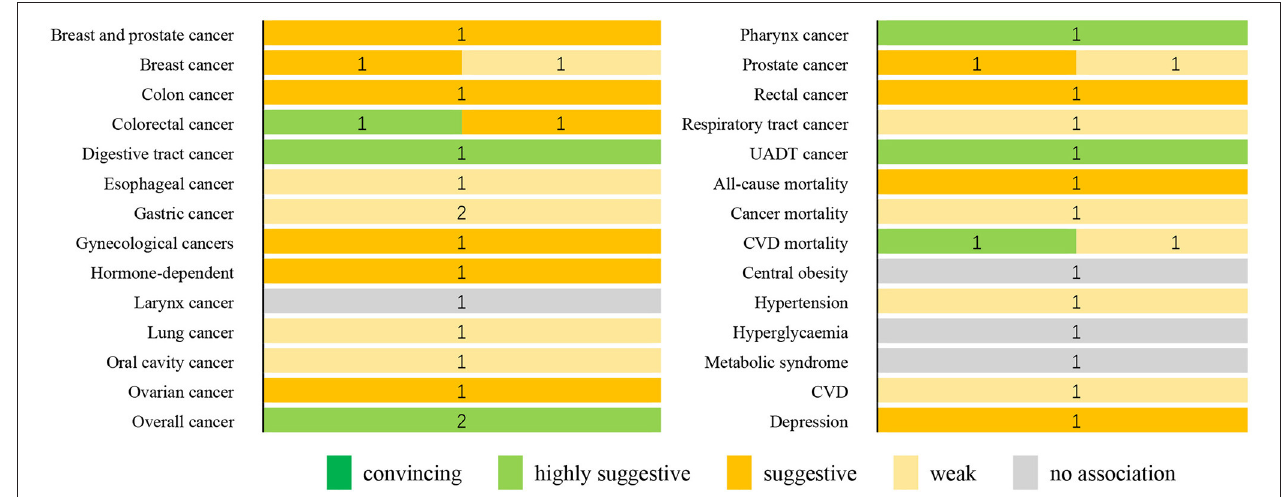
FIGURE 2 | Summary of the strength of evidence for the evaluated health outcomes. Numbers indicate the number of meta-analyses with convincing, highly suggestive, weak, or no association for each outcome. CVD, cardiovascular disease; UADT, upper aerodigestive